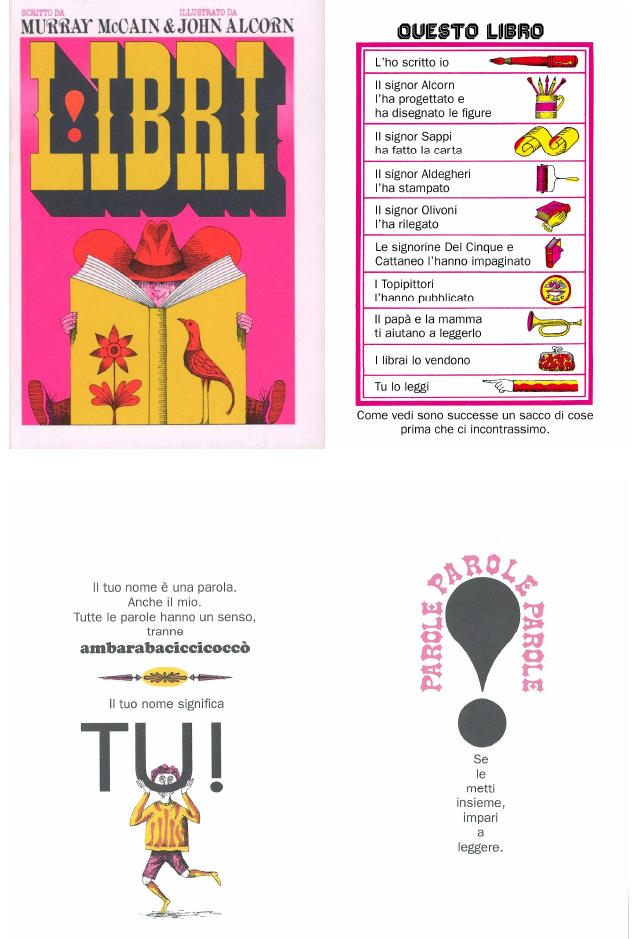
Figure A2. McCain M., Alcorn J., Libri , Milano, Topipittori, 2012.